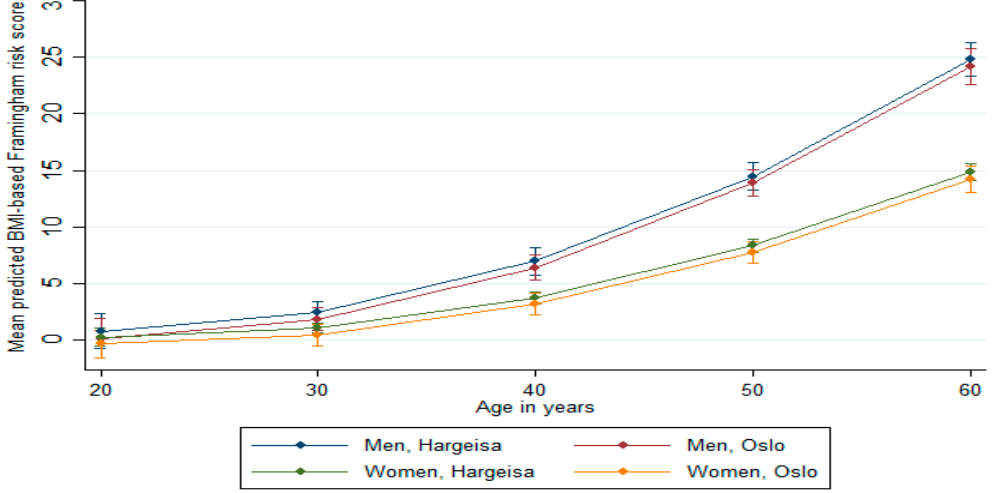
Figure 2. Body mass index (BMI)-based Framingham risk score by age, gender, and location (vertical lines are means with 95% confidence intervals).